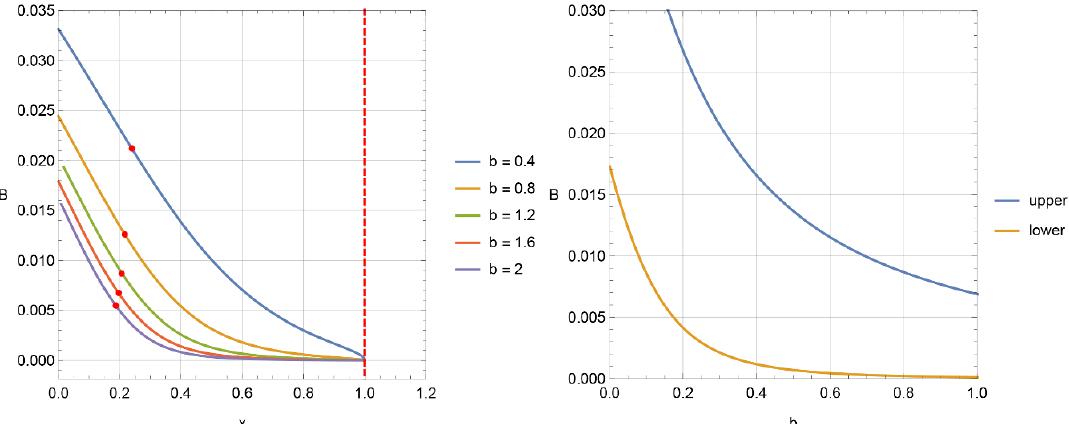
Figure 4 . Behaviour of the vacuum polarization for q = 0 : 1, (cid:3) = 1, and r c = 0 : 6; the cavity radius is indicated by the red dashed line. Left : B as a function of x (cid:17) r + =r c for various b . The red dots indicate the marginal mass along each line. Right : B as a function of b for (cid:12)xed T = 0 : 5 ( B (cid:0) b isotherms), with two